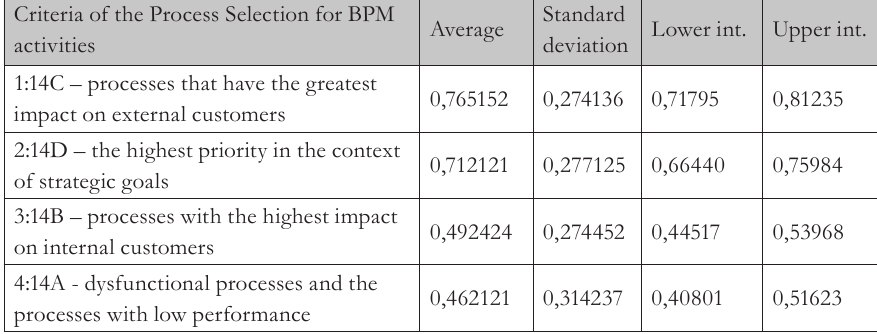
Tab. 2 - Criteria of the Process Selection for BPM activities (in 2006)- Reliability intervals (to estimate reliability 1 – α = 0,95). Source: Tuček and Zámečník 2007.